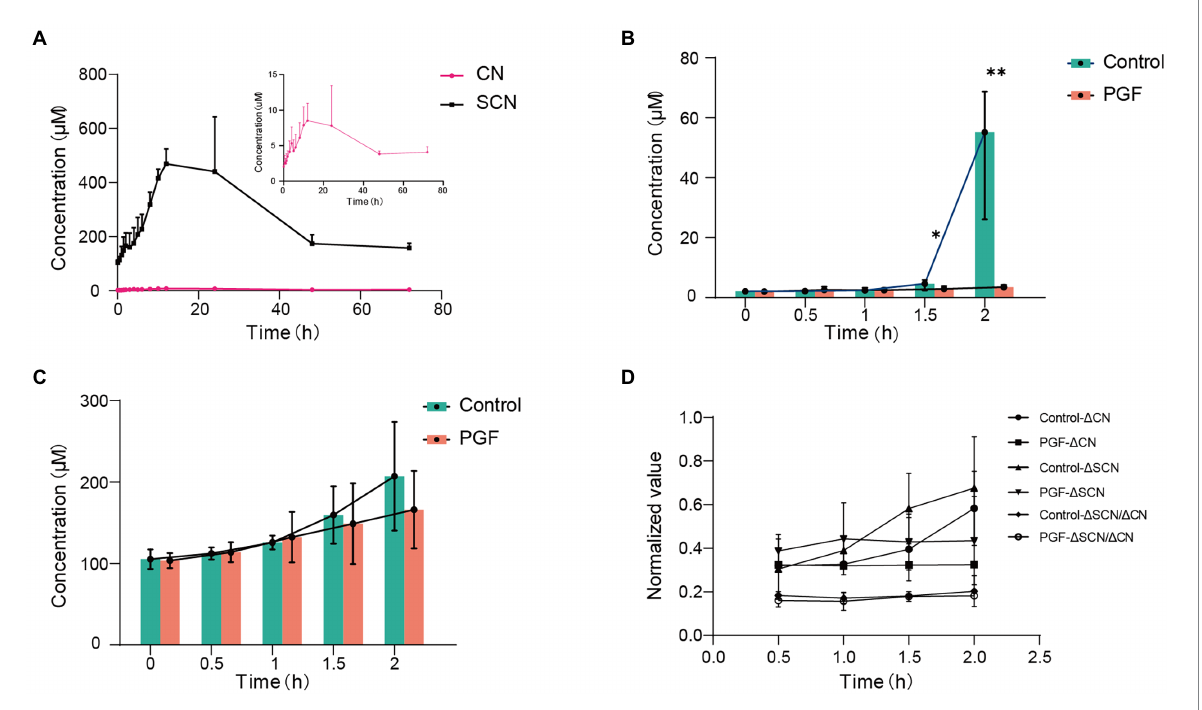
FIGURE 5 Mean plasma concentration-time profiles of CN and SCN after oral administration of amygdalin ( n = 6). (A) Overview of mean plasma concentration profiles over time for CN and SCN in the PGF group; Mean plasma concentration profiles for (B) CN and (C) SCN at 0, 0.5, 1, 1.5, 2 h after oral administration of amygdalin; (D) Increase of CN and SCN in plasma for every 0.5 h within 2 h, and the relative speed of increase was represented by their ratio. Δ : increase in plasma concentration relative to the previous sampling point. * p < 0.05 and ** p < 0.01.